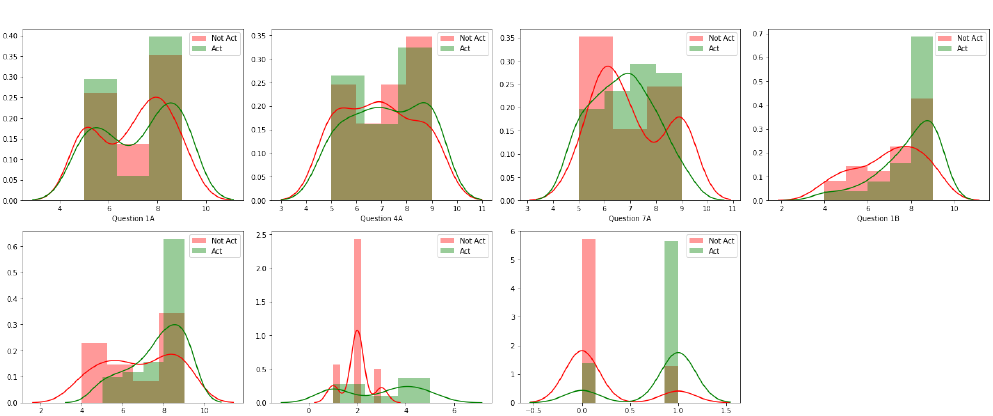
Figure 3. Distribution of variables.